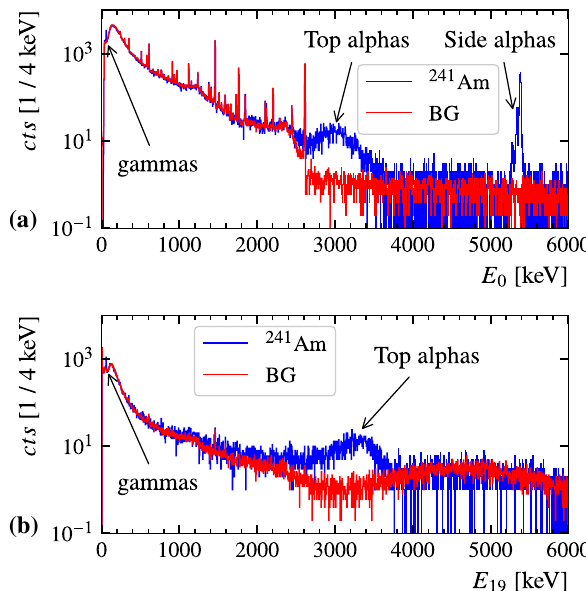
Fig. 7 a Typical raw pulse from the core channel of Super Siegfried. The three windows of the pulse are indicated by arrows and labelled. b The same pulse after calibration and cross-talk correction. The hor- izontal line in the inset in b indicates the mean of the tail of the pulse